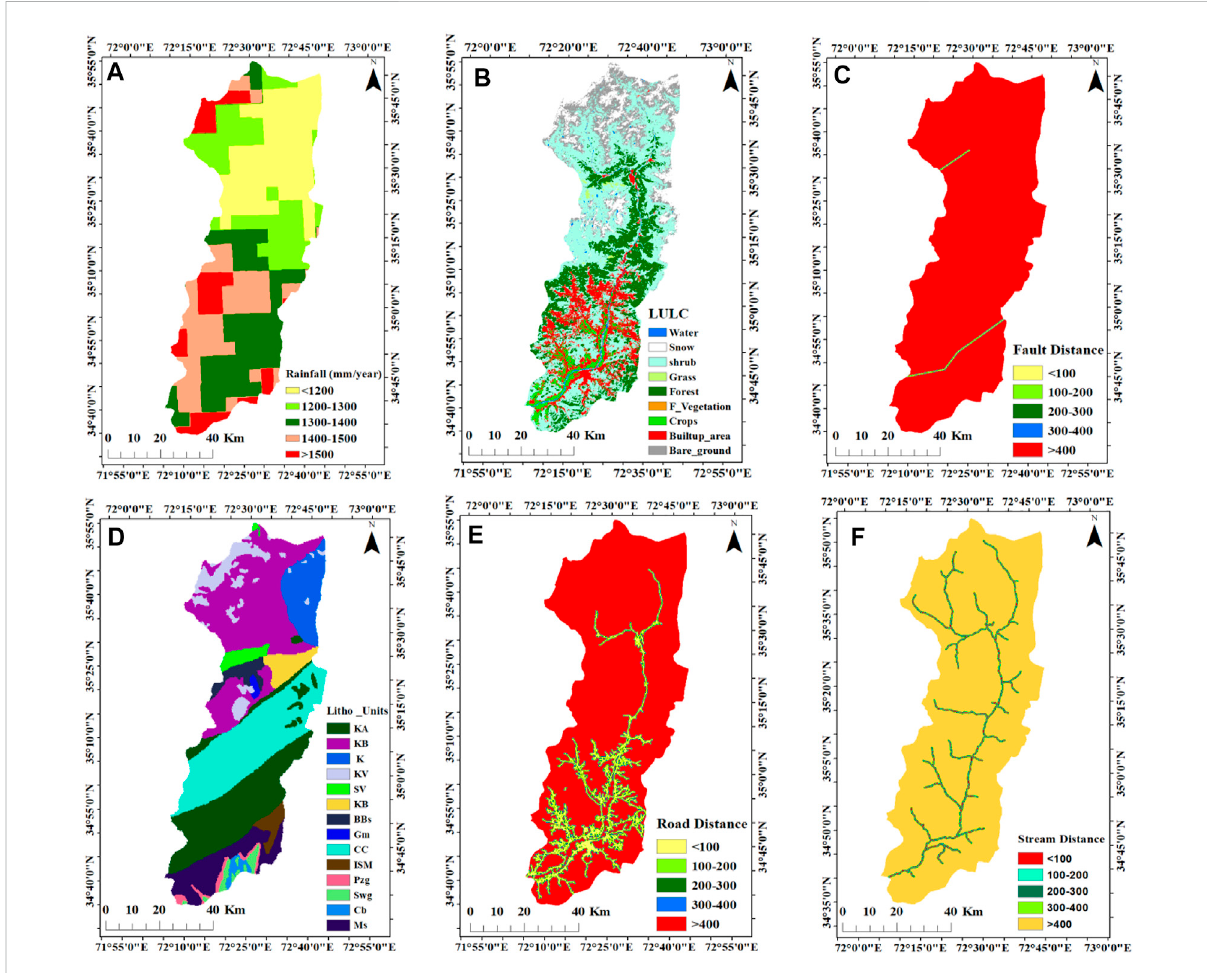
FIGURE 5 Different parameters for landslide susceptibility mapping: (A) precipitation map; (B) LULC map; (C) fault buffer; (D) lithological map; (E) road buffer; (F) stream